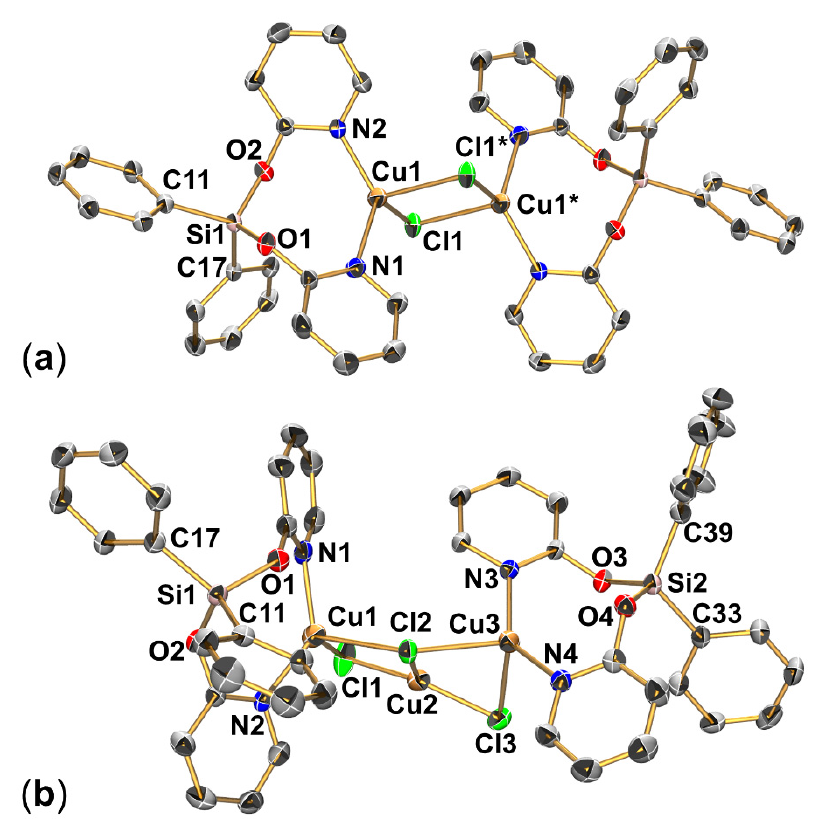
Figure 11. Molecular structures of ( a ) 5 2 and ( b ) 5 3 in its chloroform solvate 5 3 · (CHCl 3 ) with thermal displacement ellipsoids at the 50% probability level and labels of selected non-hydrogen atoms. Hydrogen atoms are omitted for clarity. Selected interatomic distances (Å) and angles (deg) for 5 2 : Cu1 − Cl1 2.301(1), Cu1 − Cl1* 2.624(1), Cu1 − N1 2.059(2), Cu1 − N2 1.996(2), Si1 − O1 1.644(2), Si1 − O2